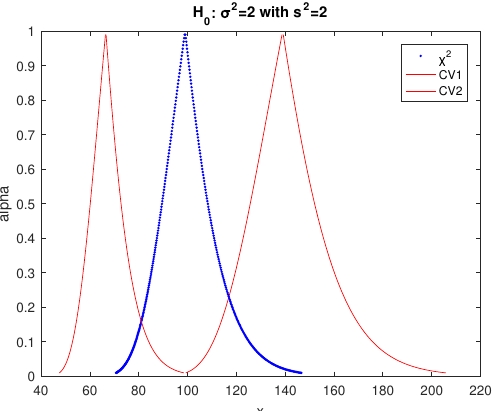
Figure 10. The possibility distribution of the fuzzy statistic (cid:102) χ 2 [ α ] and critical values for the respective test of H 0 of Example 3 in